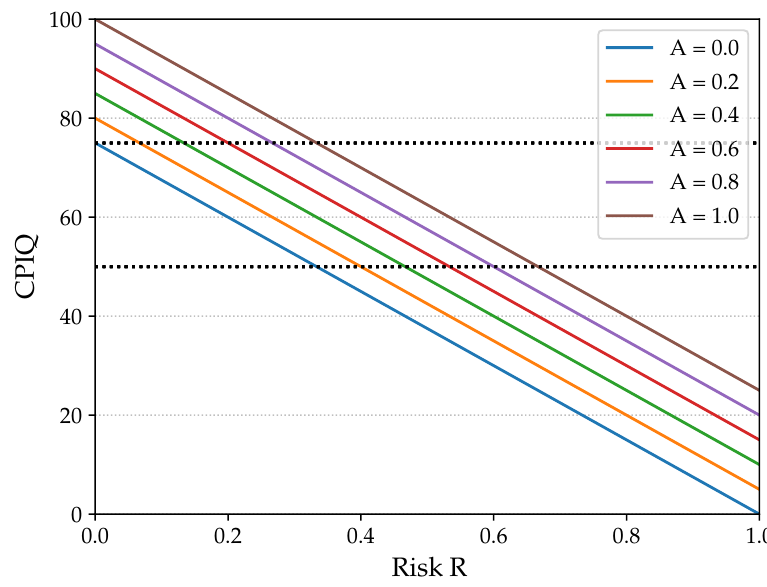
Figure 2. Consent privacy impact rating visualisation (Source: